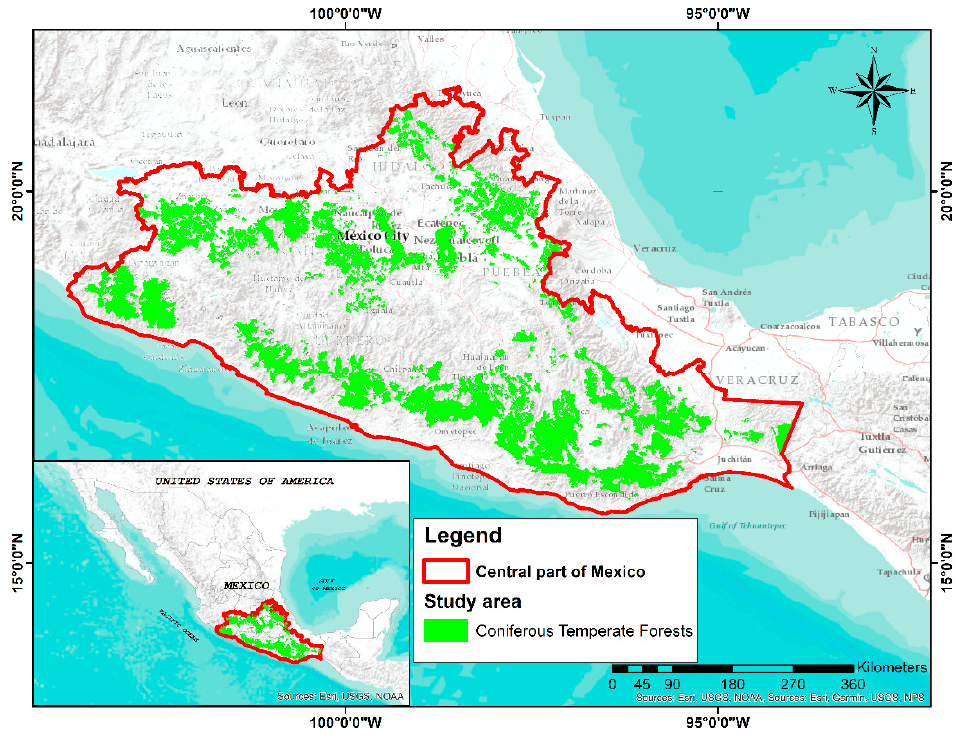
Figure 1. Study area. Table 1. Characteristics of the Pinus oocarpa reported in the literature *. Diameter at Height (m) Breast Height Altitude (masl) Temp ( ◦ C) (cm) 12–18 40–75